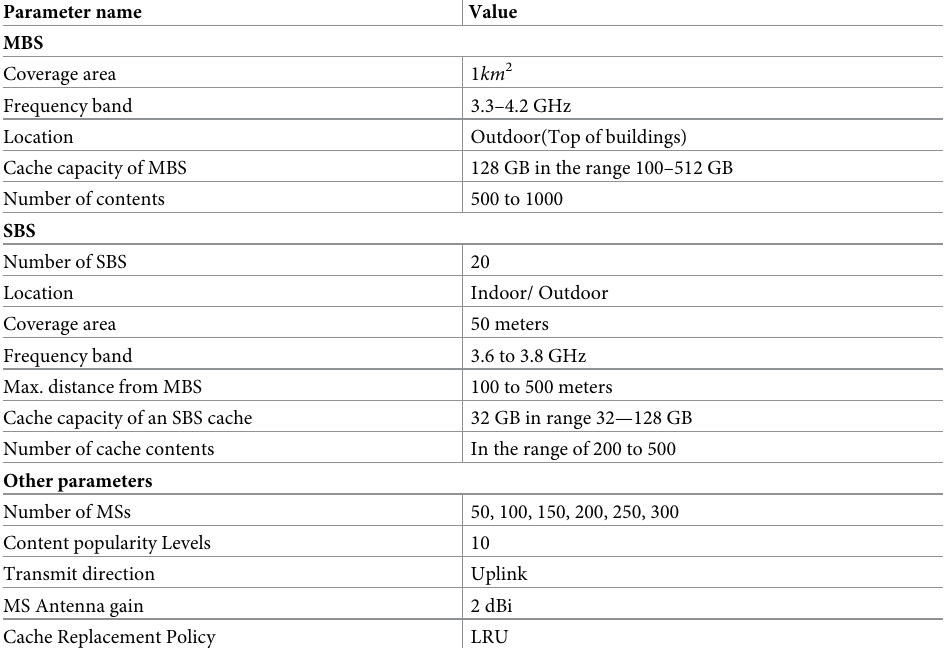
Table 3. Simulation